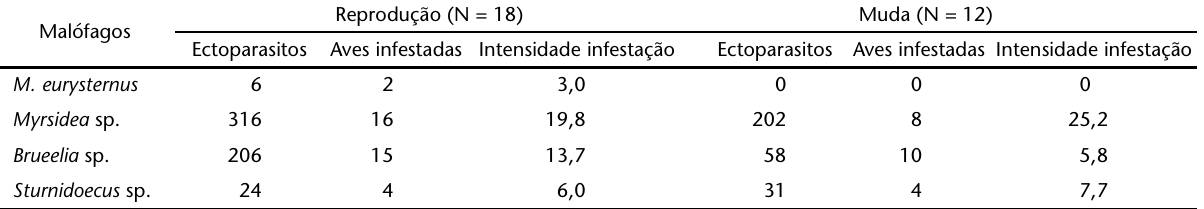
Myrsidea sp. Brueelia sp. Sturnidoecus sp.